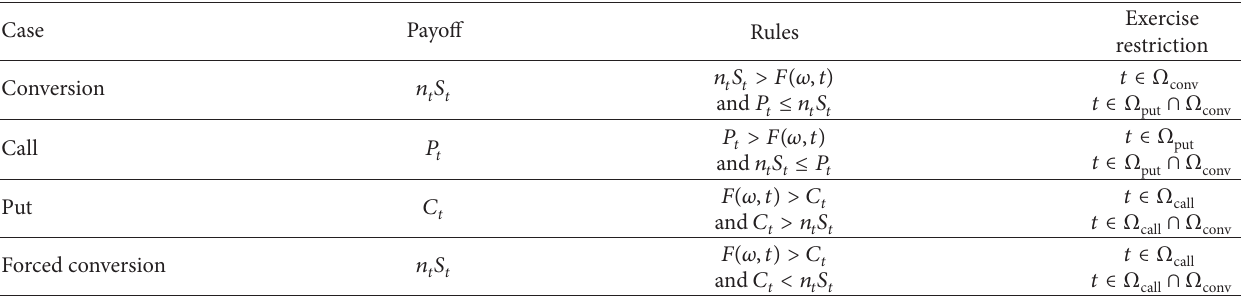
Table 1: Rules of option exercise in convertible bonds.